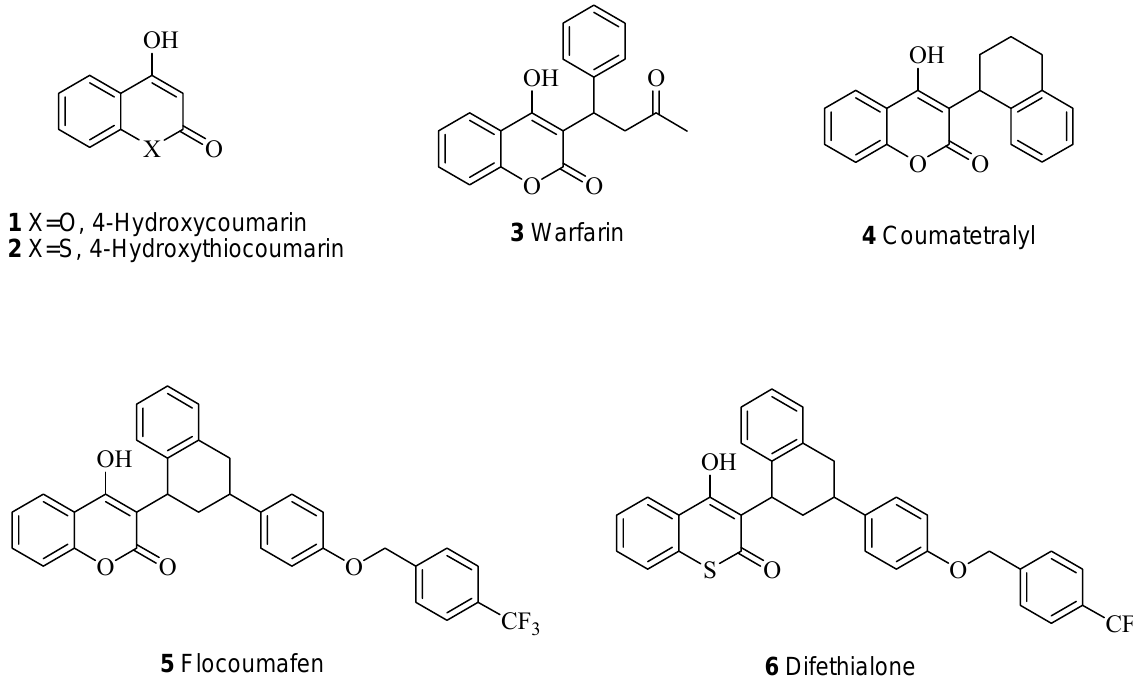
Figure 1. Structures of the 4-hydroxycoumarin ( 1 ), 4-hydroxythiocoumarin ( 2 ), and derivatives 3-6 . XOH